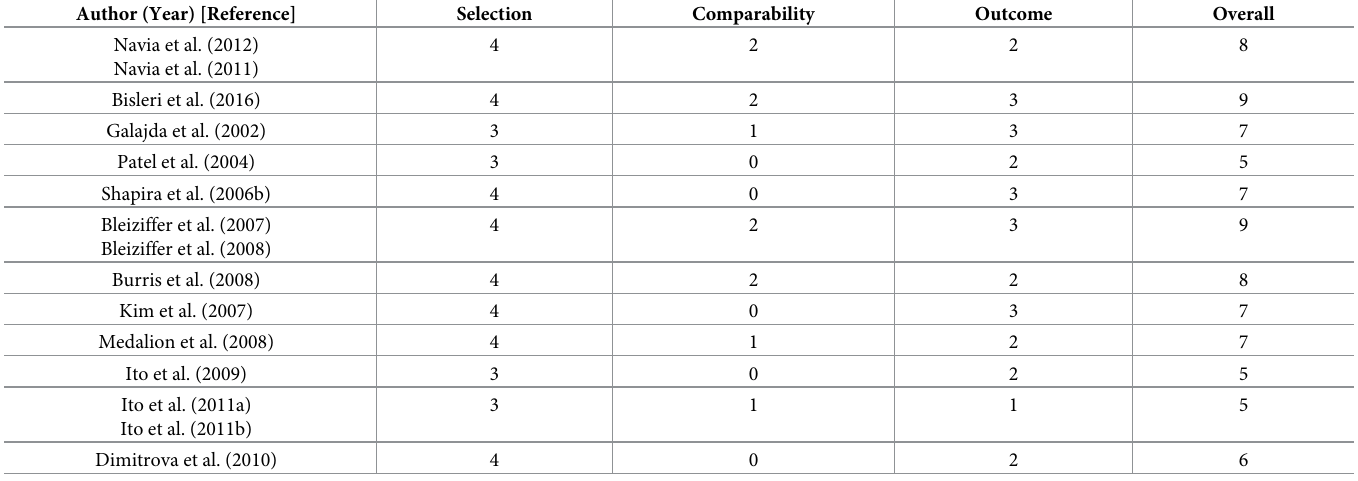
Table 4. The Newcastle–Ottawa Scale of included non-randomized control